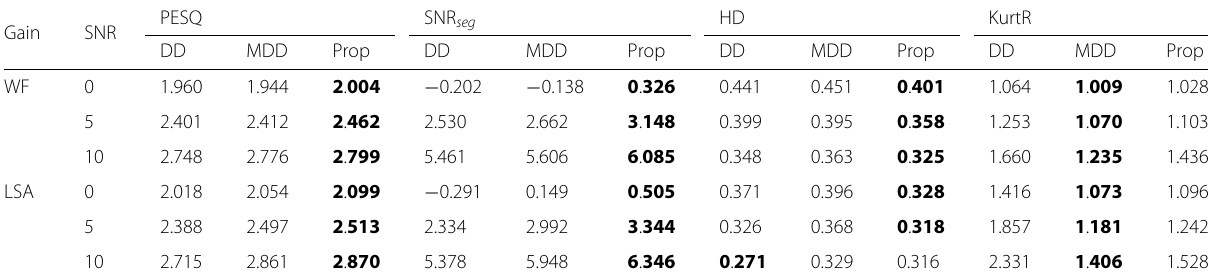
Table 9 Mean objective results for pink noise